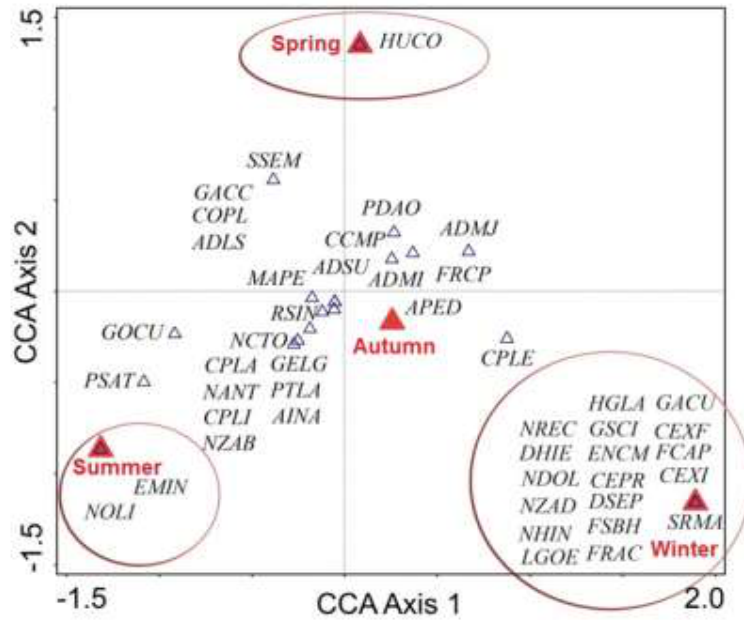
Figure 3. CCA showing the relationship between diatom taxa recorded in the Vrla River and sampling seasons. Humidophila contenta - HUCO, Sellaphora seminulum - SSEM, Geissleria acceptata - GACC, Cocconeis pseudolineata - COPL, Adlafia suchlandtii - ADLS, Mayamaea permitis -